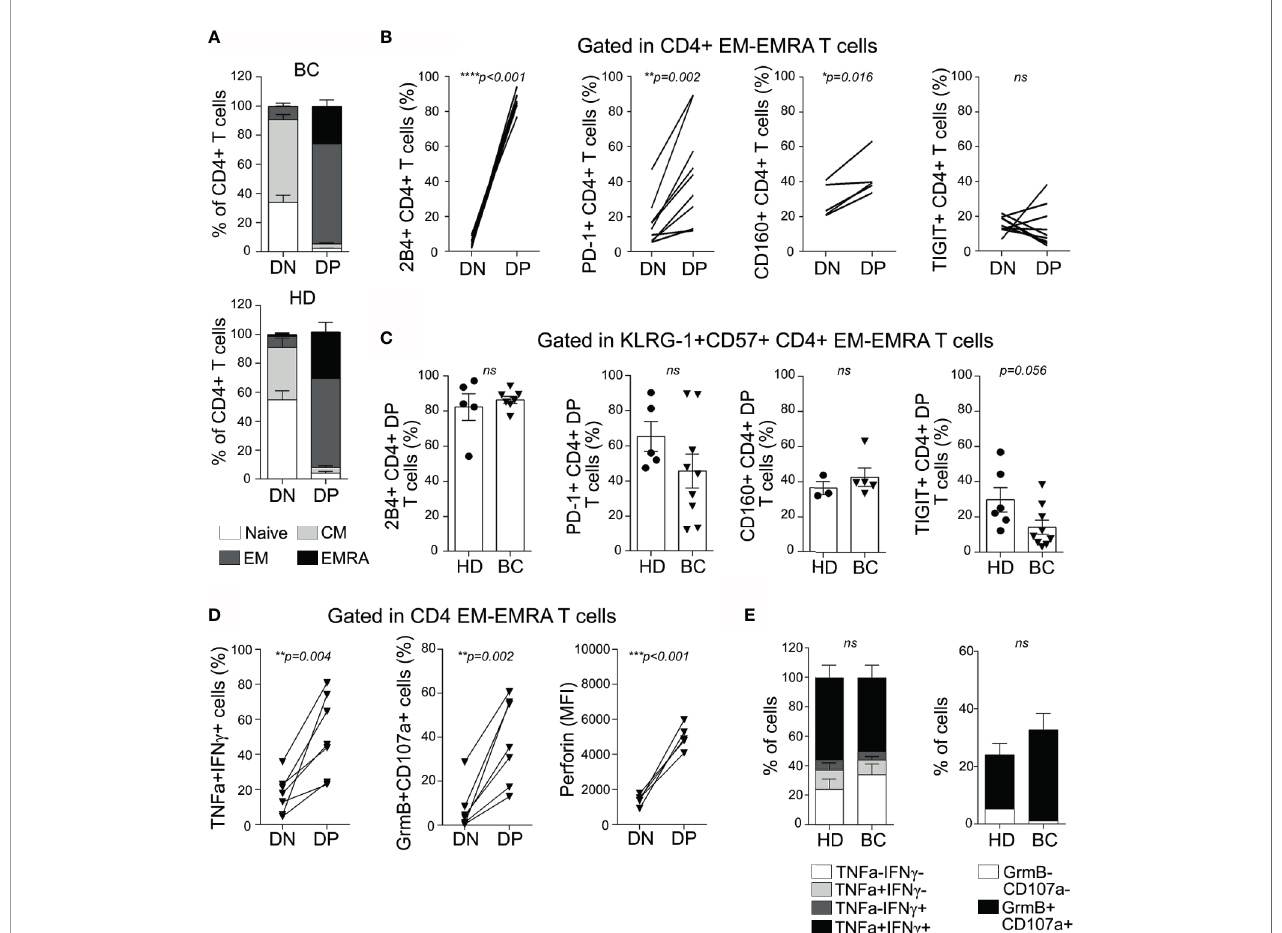
FIGURE 3 | Senescent CD4 + T cells from peripheral blood exhibit an effector-memory/EMRA phenotype, express high levels of inhibitory receptors, and are highly polyfunctional. (A) Bar graphs show proportion of naive (white), CM (light gray), EM (dark gray), and EMRA (black) cells within DN and DP CD4 + T cell subpopulations, for all BC patients (top) and HDs (bottom) analyzed. (B) Line graphs show frequency of iR-expressing CD4 + T cells within EM/EMRA populations and within DN and DP subsets as indicated in graphs. Each line represents a subject analyzed. (C) Bar graphs show iR-expressing CD4 + T cells within KLRG-1 + CD57 + EM/EMRA population from BC patients and HDs. Unpaired t -tests were used to compare iR expression between DN and DP subsets in each sample (HD or BC). (D) Line graphs show frequency of BC patients ’ CD4 + T cells co-expressing TNF and IFN g or Granzyme B and CD107a (after PMA/Ionomycin stimulation) or expressing Perforin ( ex vivo ), within EM/EMRA populations and within DN and DP subsets as indicated in graphs. Each line represents a subject analyzed. Paired t -tests were used to compare functionality between DN and DP subsets ( p are indicated in each graph). (E) Bar graphs show proportion of KLRG-1 + CD57 + CD4 + T cells expressing the indicated cytokines or cytotoxic-associated molecules in HDs and BC patients. Unpaired t -test was applied to compare HD vs BC (ns, not signi fi